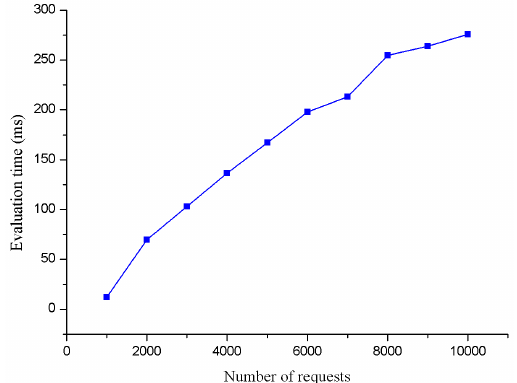
Figure 10. Evaluation performance of modified policy set.